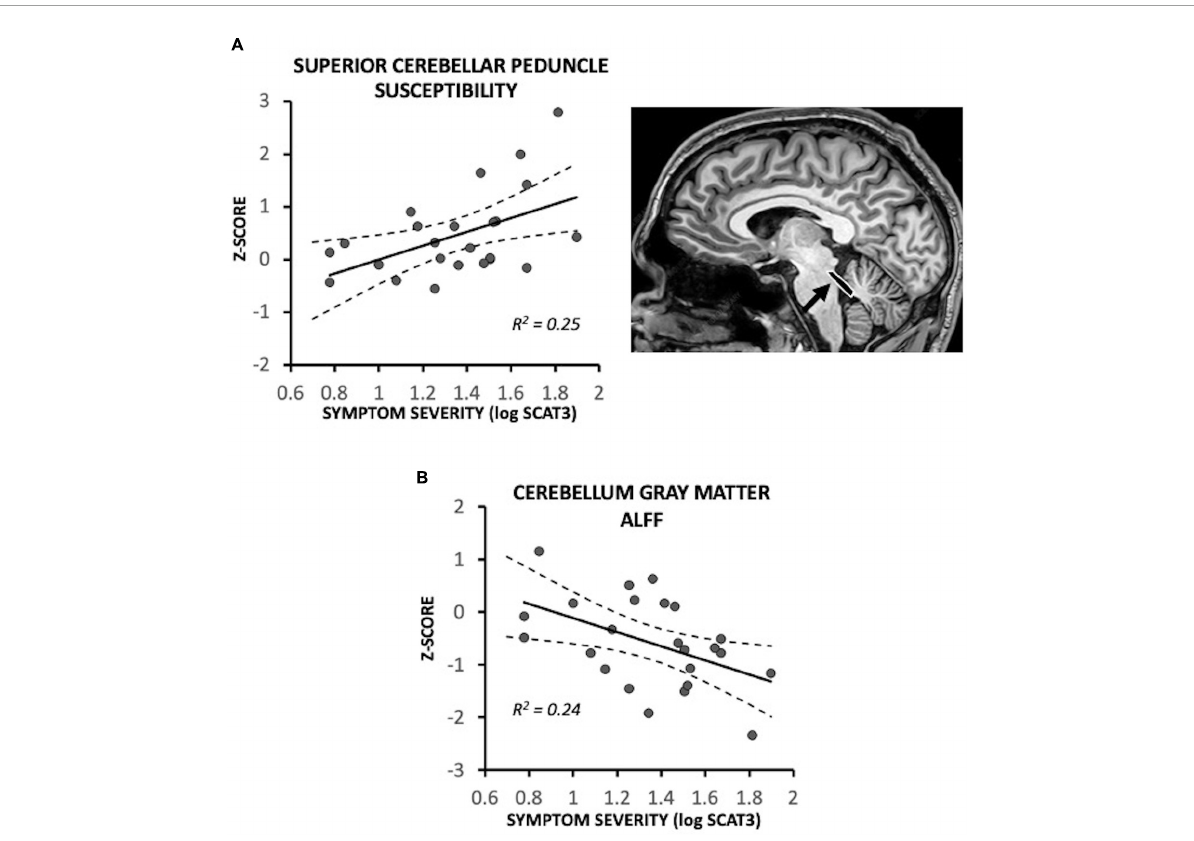
FIGURE2 Magnetic resonance imaging (MRI) measures associated with symptom severity in symptomatic recently concussed youth ( N = 24), expressed as a Z-score relative to control participants ( N = 20). Greater symptom severity was significantly associated with (A) increased susceptibility in the superior cerebellar peduncles ( p = 0.011) and (B) decreased ALFF of the cerebellum ( p = 0.013). Low symptom severity was associated with near control participant levels (i.e., Z =